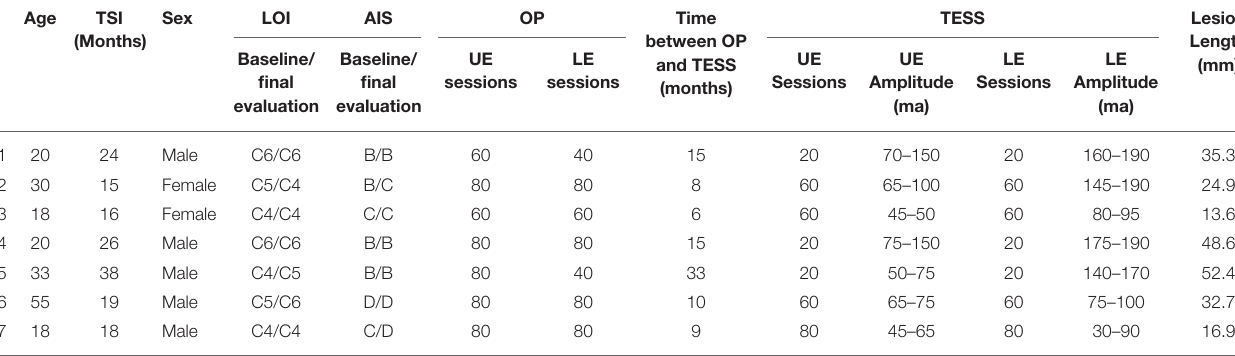
TABLE 1 | Individual’s demographic, injury, and session information at